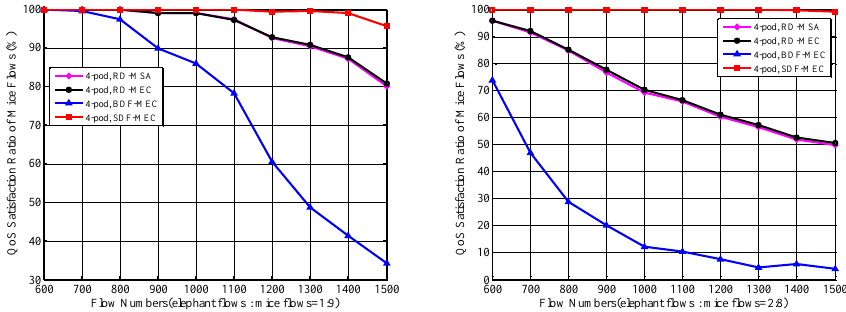
Figure 8. QoS satisfaction ratio of mice flows in 4-pod Fat-Tree.